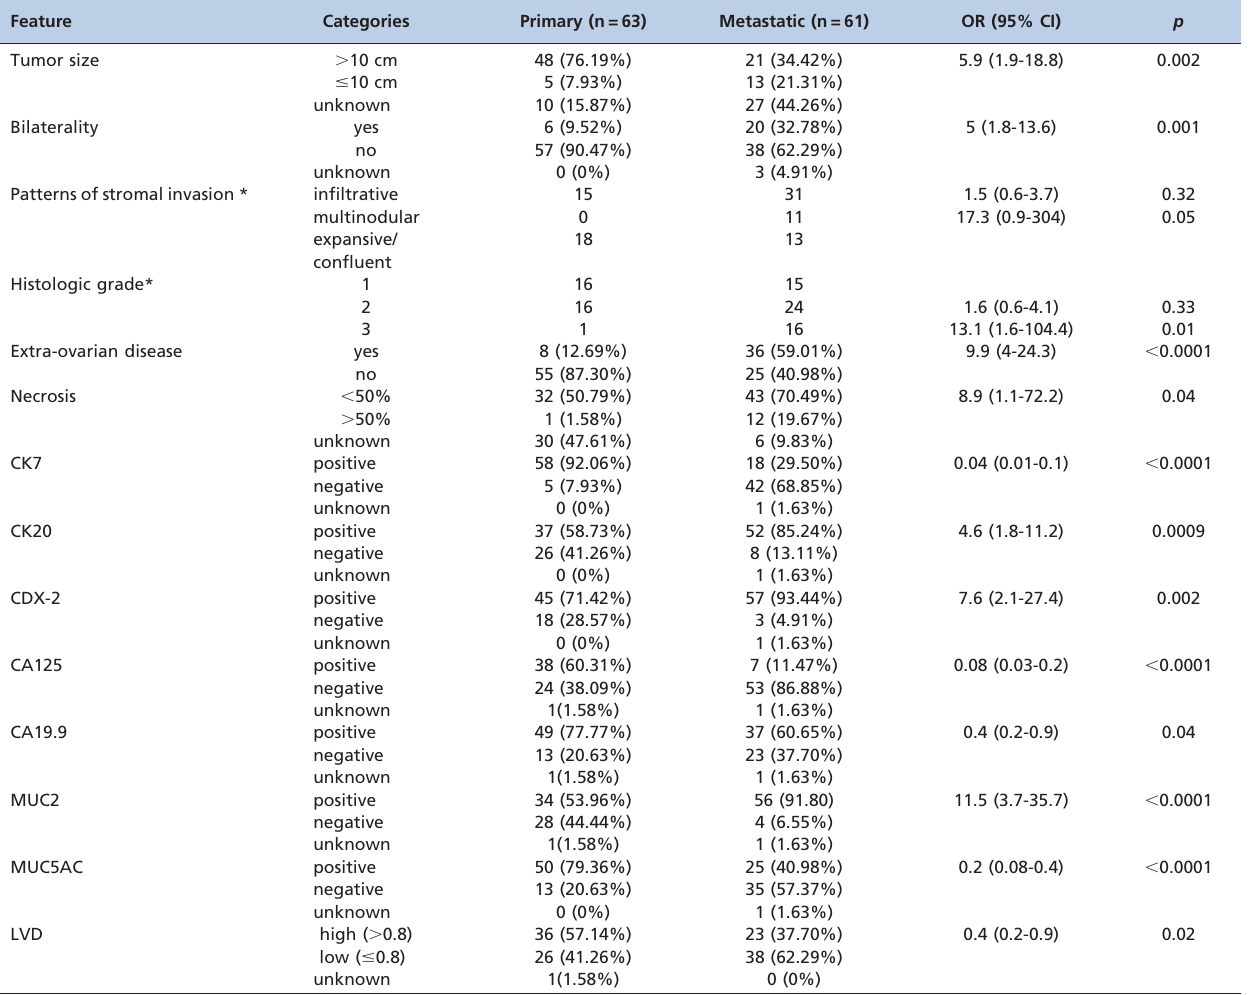
Table 3 - Surgical-pathological variables and immunohistochemical characteristics of 124 cases of mucinous ovarian